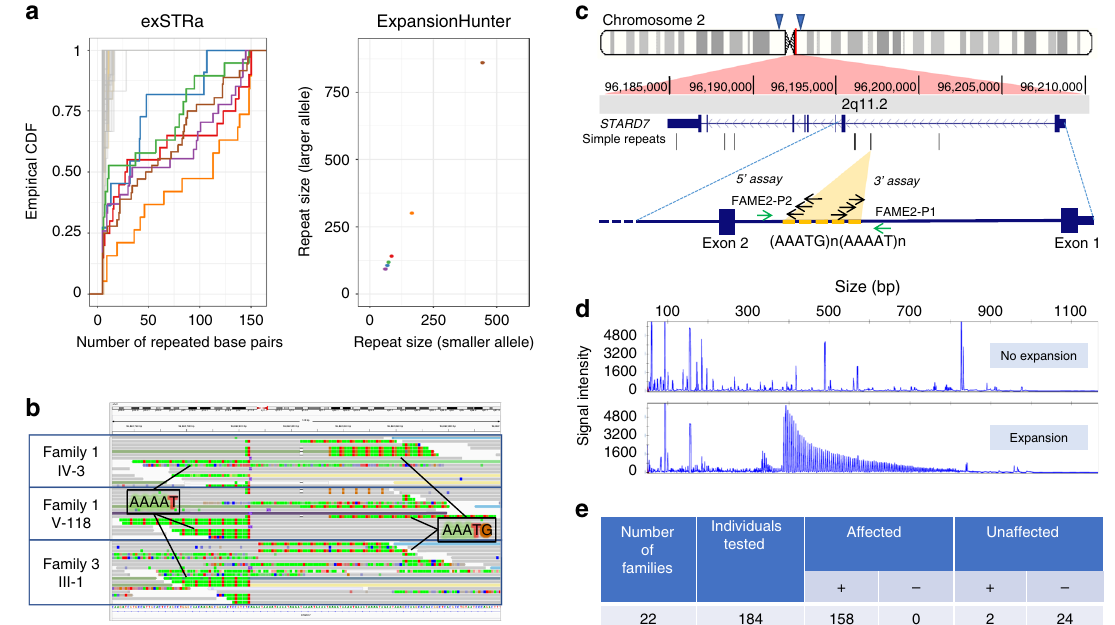
Fig. 1 Identi fi cation of an expanded pentameric ATTTC repeat causing FAME2. a Estimated sizes of the AAATG repeats in two affected individuals from Family 1 (red, orange), one from Family 3 (brown) and three affected individuals from Family 19 (blue, green, purple), compared to 69 individuals without FAME using TruSeq Nano (grey) or KAPA Hyper (tan) library preparation. Left panel shows empirical cumulative distribution functions from exSTRa panel while the right panel shows the estimated repeat size by Expansion Hunter (the sum of both alleles suggests repeat sizes of 0.75 – 2.3 kb). Data underlying this part of the fi gure are available in Source Data. b WGS data from two individuals in Family 1 and one from Family 3 show reads suggesting expansion of AAAAT and insertion of AAATG repeats in the chr2 linkage interval. c Upper section shows the location of the repeat in the context of chr2. The approximate location of the FAME2 minimal linkage interval is shown above the ideogram with two blue arrow heads. The STARD7 gene is on the reverse chromosome strand and the endogenous AAAAT repeat is found in the fi rst intron of the gene. Schema in the lower section shows the primers used in the RP-PCR to detect the ATTTT “ 3 ′ assay ” and ATTTC “ 5 ′ assay ” expanded repeats, respectively. d Example results of the RP-PCR 5 ′ assay obtained in an individual negative for the ATTTC insert (top panel) and in an individual affected by FAME, positive for the ATTTC repeat insertion (bottom panel). Full screening results are provided in Supplementary Data 1. e Summary of 184 individuals from 22 families tested with the RP-PCR assay. Individuals under category ( + ) tested positive for the ATTTC repeat and individuals under category ( − ) tested negative for the